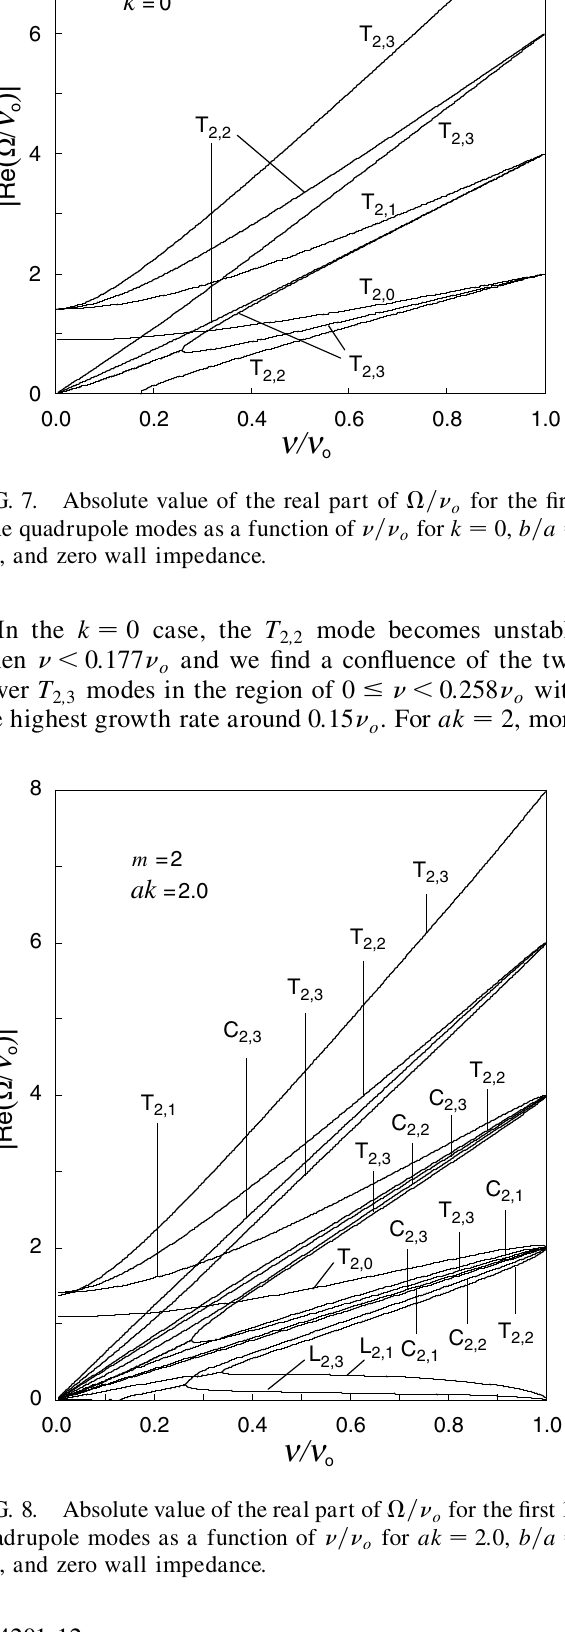
for the first 18 o for ak (cid:3) 2 : 0 , b=a (cid:3) o